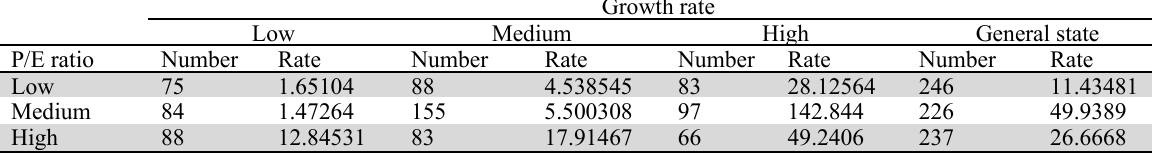
Overall ranking of firms based on P/E ratio during 5 years